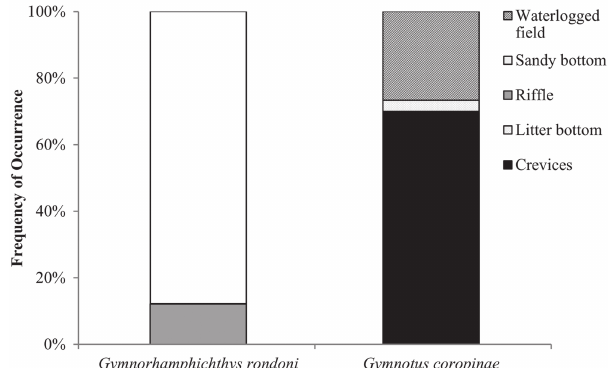
Fig. 2. Habitat use (frequency) of Gymnorhamphichthys rondoni and Gymnotus coropinae sampled in five different microhabitats in first to third order streams at the Saracá- Taquera National Forest, Oriximiná, Pará. Gymnorhamphichthys rondoni and Gymnotus coropinae consumed 18 food items each, 17 of those consumed by both species, and only one was consumed exclusively by only one of the species (Tab. 1): Algae by G. rondoni and Decapoda by G. coropinae . The most important item consumed by both species was Sediment/Detritus (IAi = 41.92% and 32.72%, respectively). Other important items were Ceratopogonidae and Chironomidae larvae for G. rondoni (IAi = 32.99% and 18.85%, respectively), and Chironomidae and Ceratopogonidae larvae for G. coropinae (IAi = 21.59% and 16.81%, respectively). Plant remains were not important in the diet of G. rondoni (IAi = 0.09%), but slightly more consumed by G. coropinae (IAi =